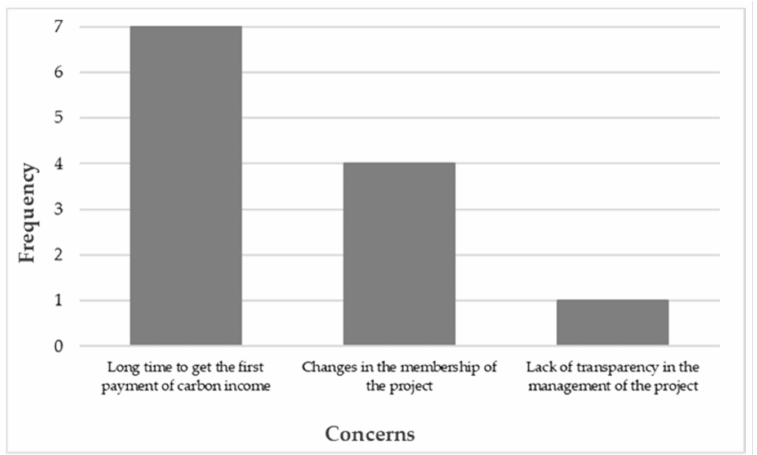
Figure 6. Concerns associated with the presence of PES project and their importance according to the